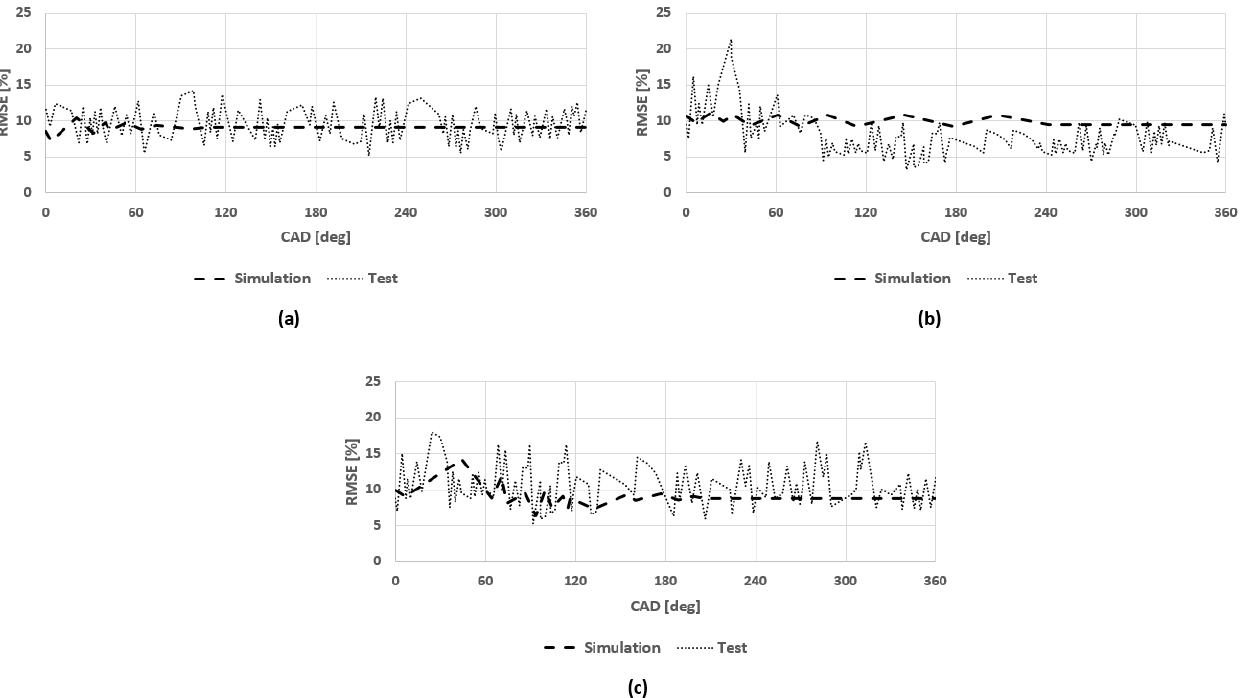
Figure 15. The RMSE analysis of the two-stage turbine system with rotor A turbine at the turbine speed ( a ) 40,000 rpm, ( b ) 50,000 rpm and ( c ) 60,000 rpm.